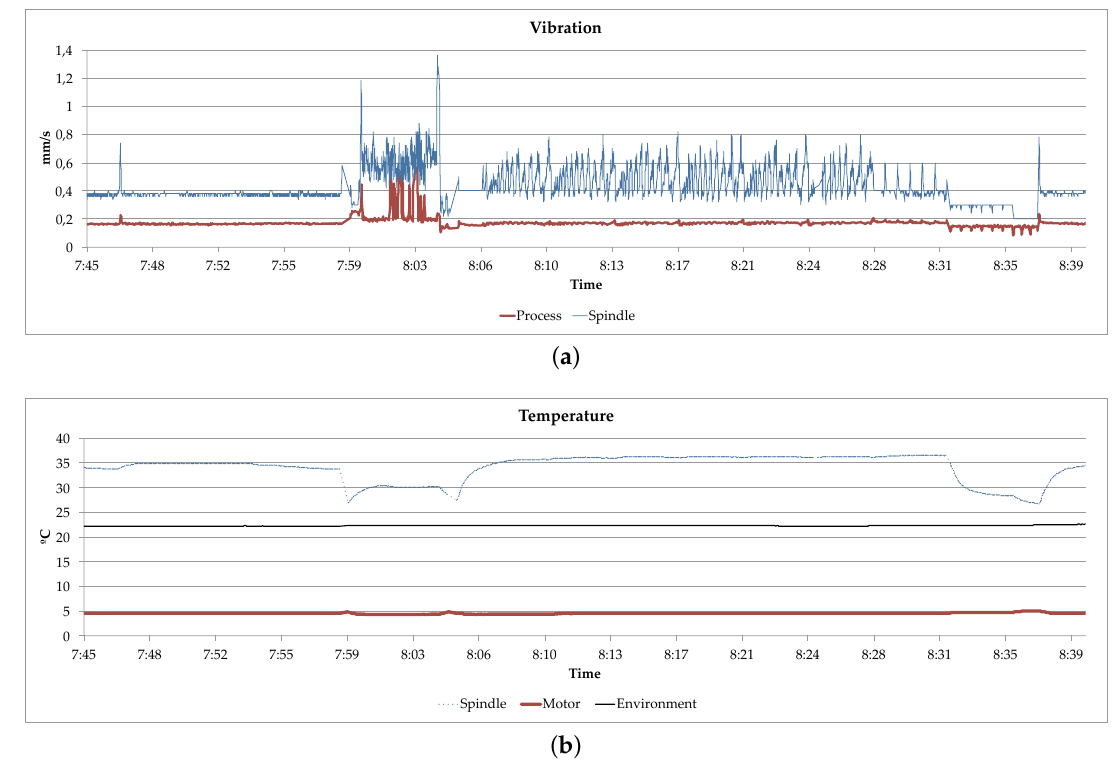
Figure 7. Milling Machine Predictive Maintenance Display. ( a ) Milling Machine Vibration; ( b ) Milling Machine